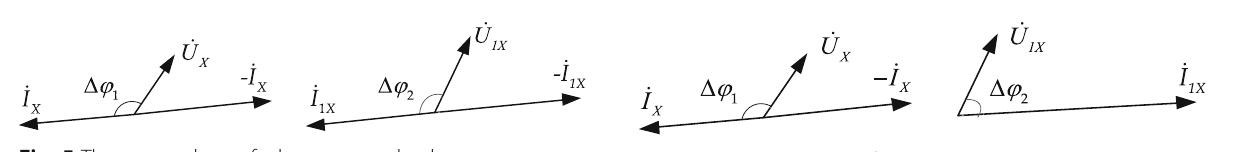
Fig. 7 The pre- and post-fault current and voltage vector graphs of X terminal of situation (4)